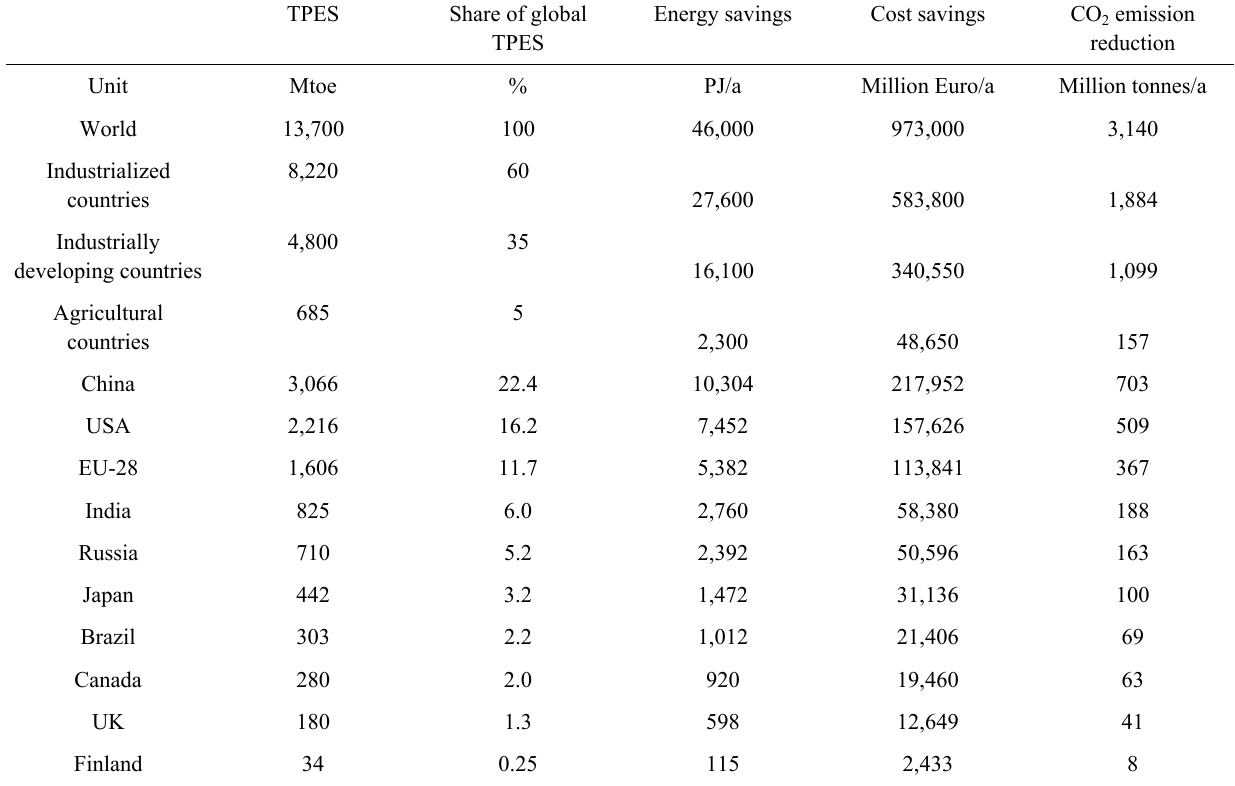
Fig. 12 Potential annual energy, cost and CO 2 emission savings globally after 8 years of intensive advanced tribology implementation. Table 4 Estimated potential energy and cost savings, and CO 2 emission reduction on long term (15 years) by region calculated as related to the total primary energy supply (TPES) of each